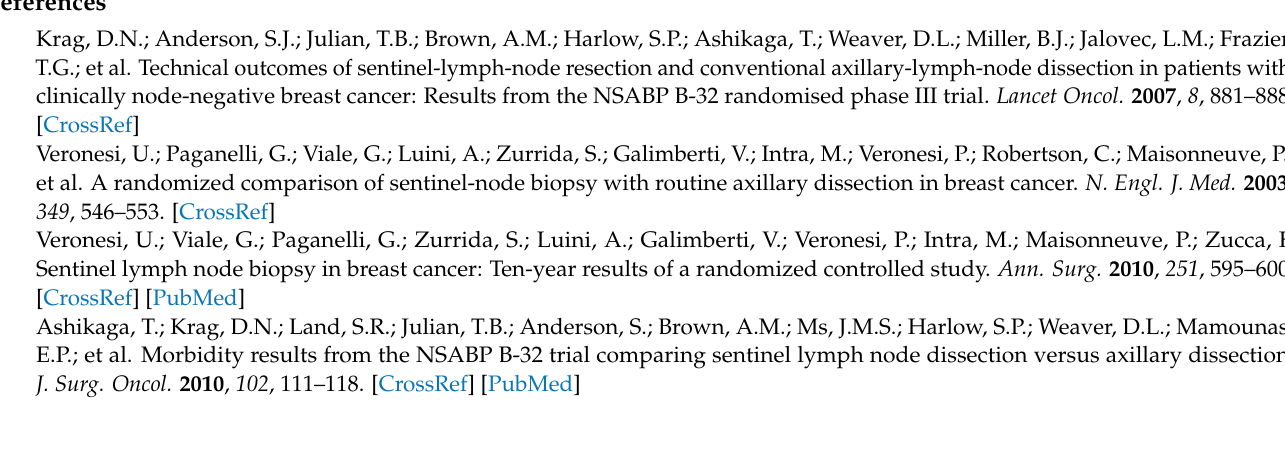
Detailed information of the SPIO; Table S2: ROBINS-I. Figure S1: Subgroup analysis of patient identi- fication rates for SPIO versus standard method (fixed-effects model), stratified through the selection of the standard method.; Figure S2: Subgroup analysis of SLN identification rates for SPIO versus standard method (random-effects model), stratified through the selection of the standard